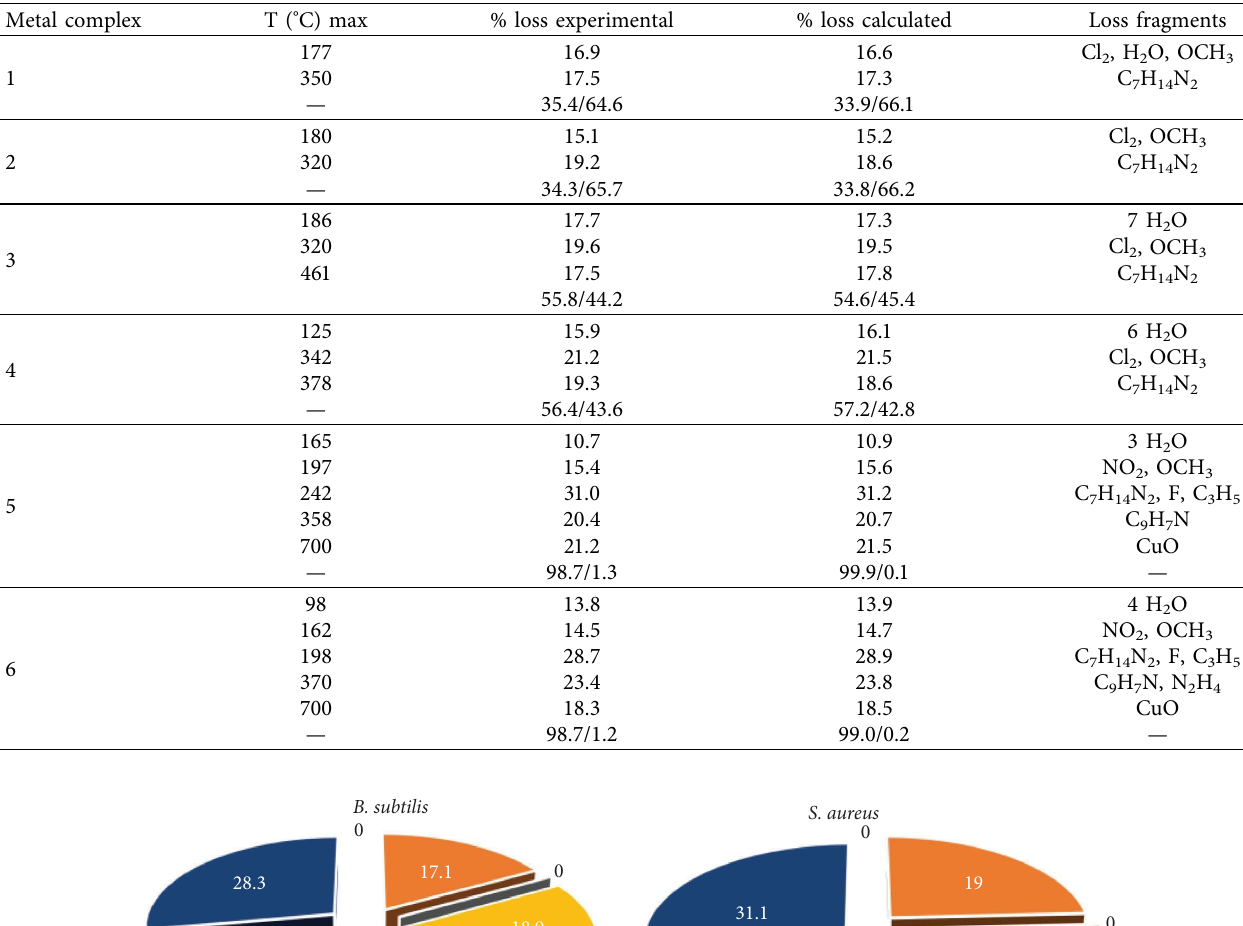
Table 5: Te fragments/mass loss of complexes 1–6 at the respective temperature range.